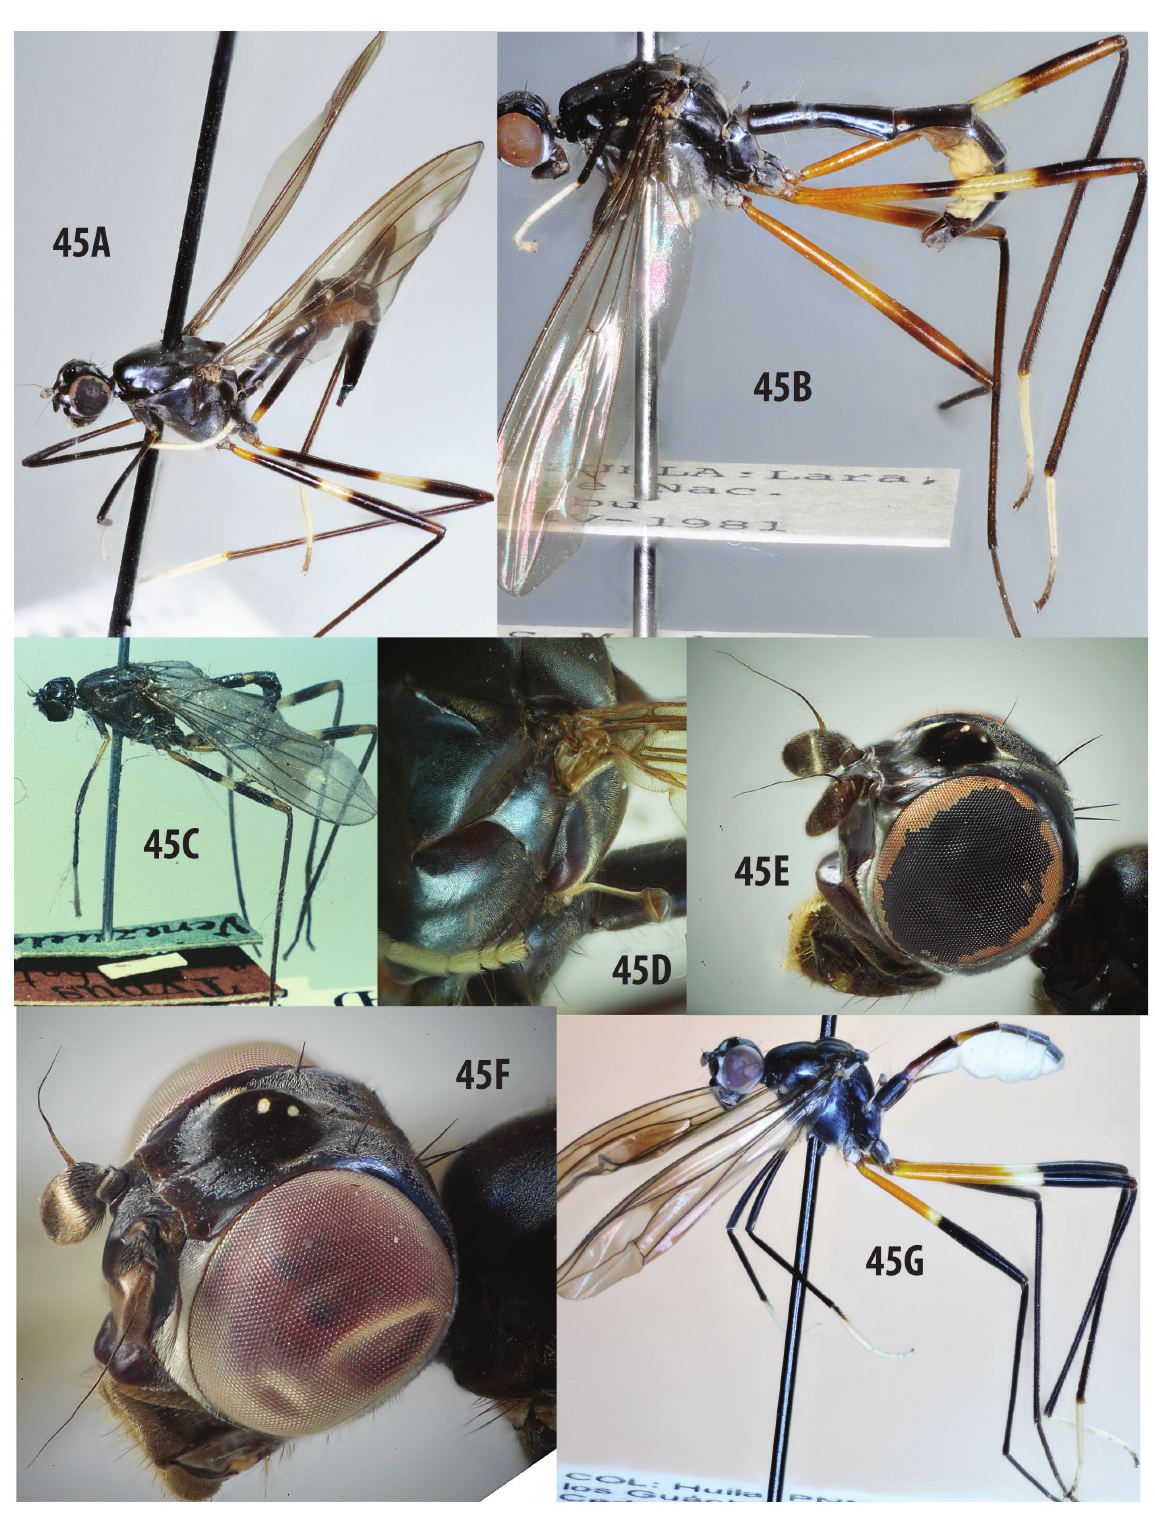
Fig. 45. Mesoconius oblitus (Hennig, 1935), external characters. A . Typical ♀, DEBU, Venezuela. B . Colour variant, ♂, USNM, Venezuela. C . Holotype, ♂, SMTD. D . Posterior part of thorax, lateral view. E . Head, ♀, DEBU, specimen from Venezuela. F . Head, ♀, IAVH, specimen from Colombia. G . Colour variant, ♀, IAVH, oviscape removed, specimen from